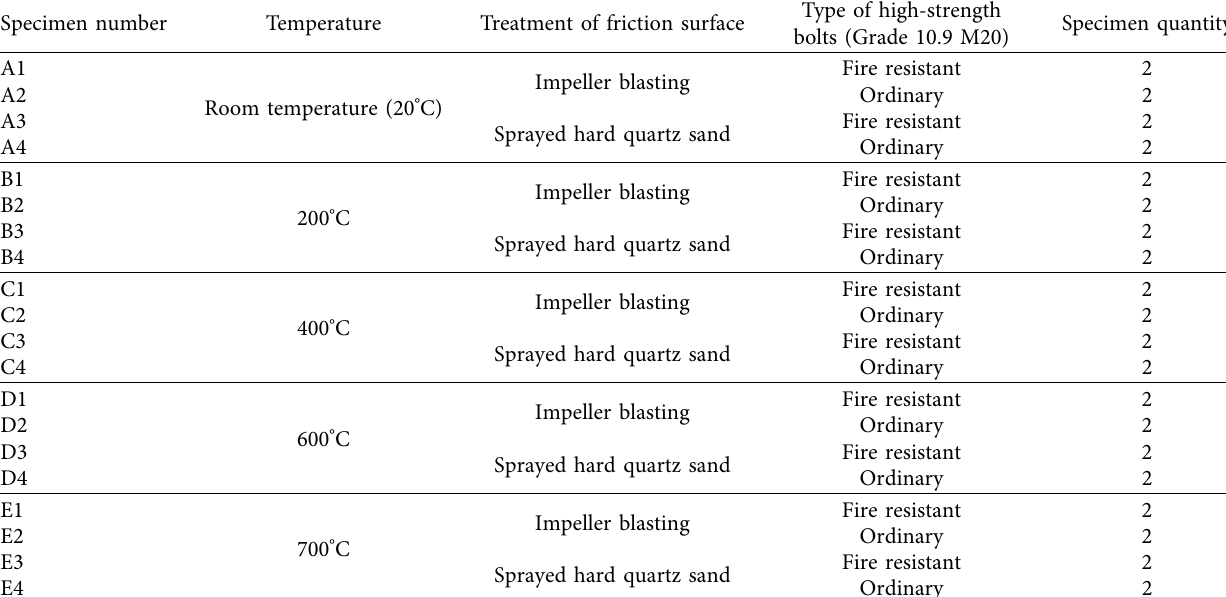
Table 4: Experimental condition and parameters of the